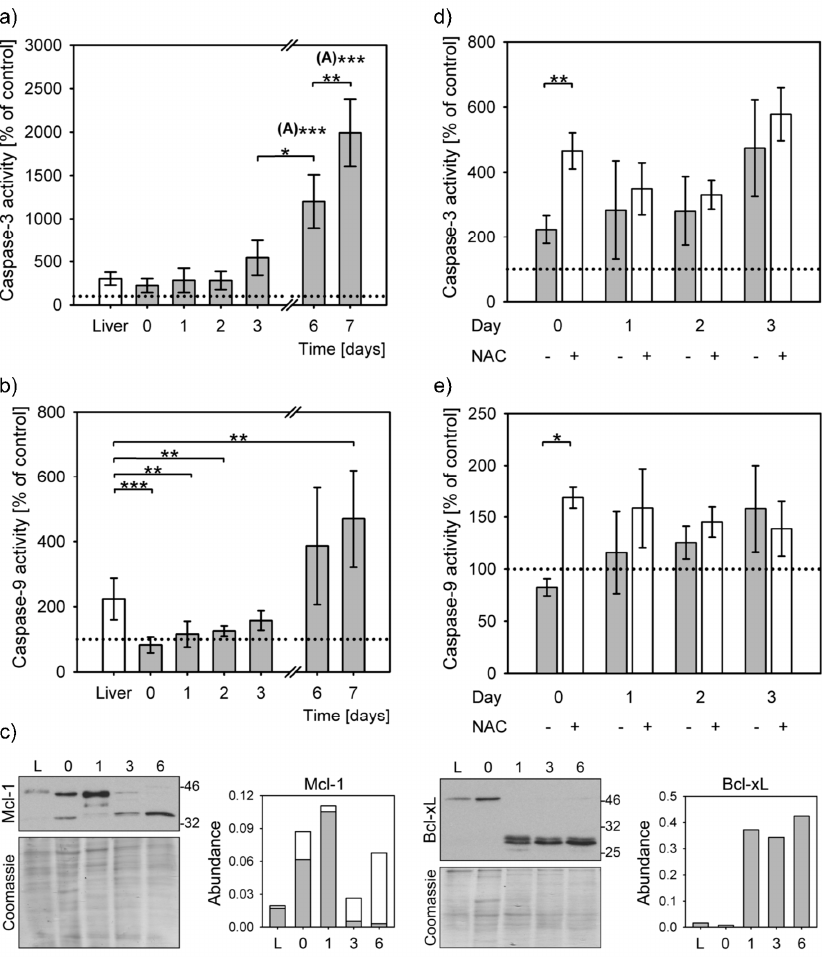
Figure 3. Apoptosis initiation. Caspase activation was induced in staurosporine (STS) treated precision cut liver slices (liver) and hepatocyte cultures from isolation (day 0) to day 7. Bar charts represent caspase activation in STS treated samples normalized to their untreated controls (means ± SD). Caspase activity of untreated controls is indicated by a dotted line. Statistical significance is represented by “*” symbols (*: P < 0.05, **: P < 0.01, ***: P < 0.001). “(A)”: significantly differs to all other time points/categories. ( a ) Activation of caspase-3 in liver slices (white bars) and in primary hepatocytes (grey bars). Caspase-3 activation significantly differs among the STS-treated liver slices and primary hepatocytes ( P = 1 × 10 − 7 , Kruskal–Wallis rank sum test). Apoptosis activation on days 6 and the following time points/categories: liver slices P = 0.001; day 0: P = 4 × 10 − 4 ; day 1: P = 4 × 10 − 4 ; day 2: P = 4 × 10 − 4 ; day 3: P = 0.027; day 7: P = 0.006; Dunnett T3 post hoc test. Apoptosis activation on day 7 and: liver slices P = 10 − 5 ; day 0: P = 7 × 10 − 6 ; day 1: P = 5 × 10 − 6 ; day 2: P = 4 × 10 − 6 ; day 3: P = 7 × 10 − 5 ; Dunnett T3 post hoc test. ( b ) Caspase-9 activation in liver slices (white bars) and in primary hepatocytes (grey bars) differs overall among all time points ( P = 9 × 10 − 9 , Kruskal-Wallis rank sum test). The differences between the liver slices and primary hepatocytes at the following time points